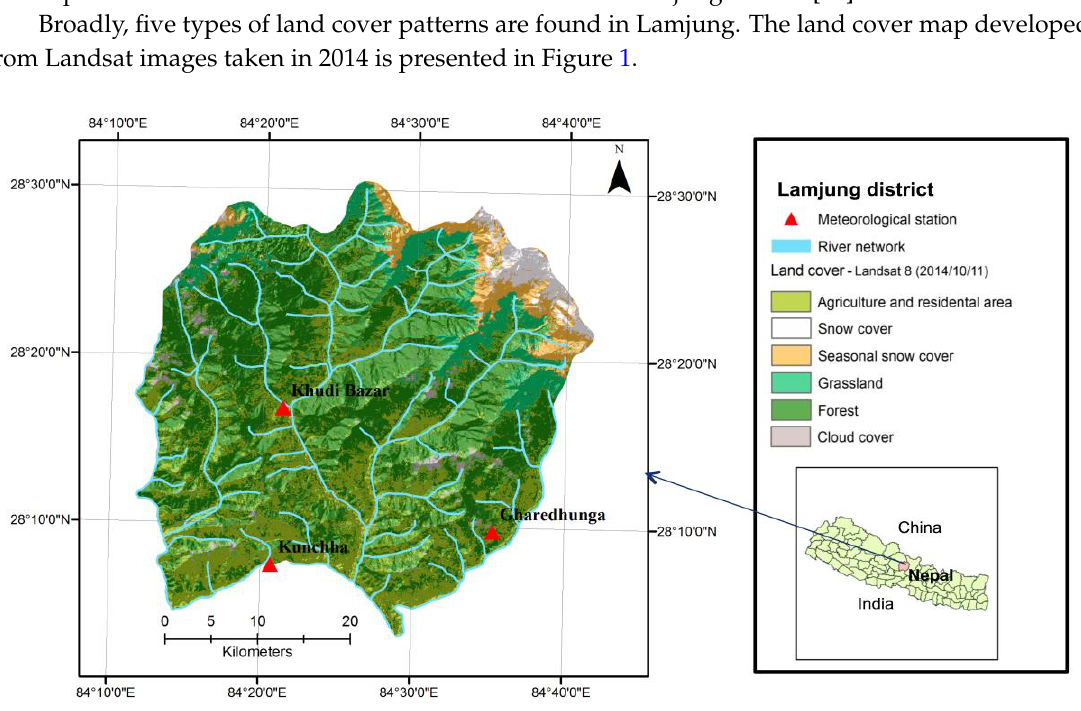
Figure 1. Land cover map of Lamjung district, developed from Landsat 8 images.